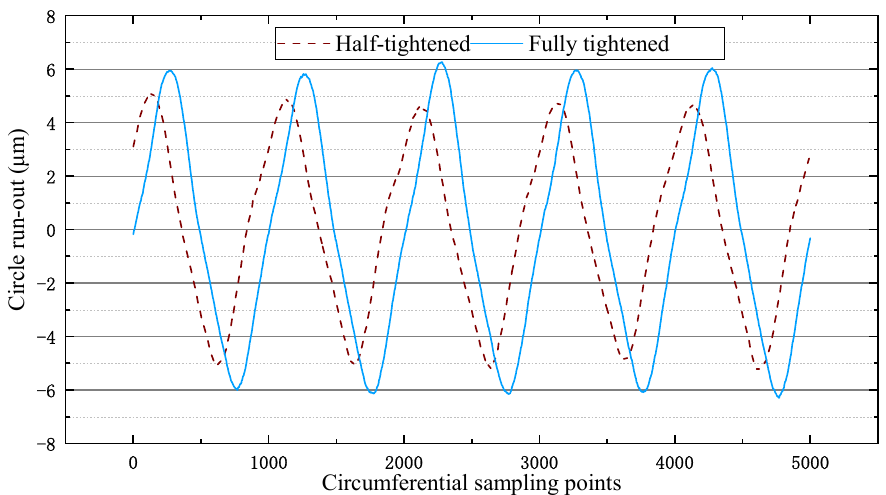
Figure 8. Graph of nut tightness experimental results.